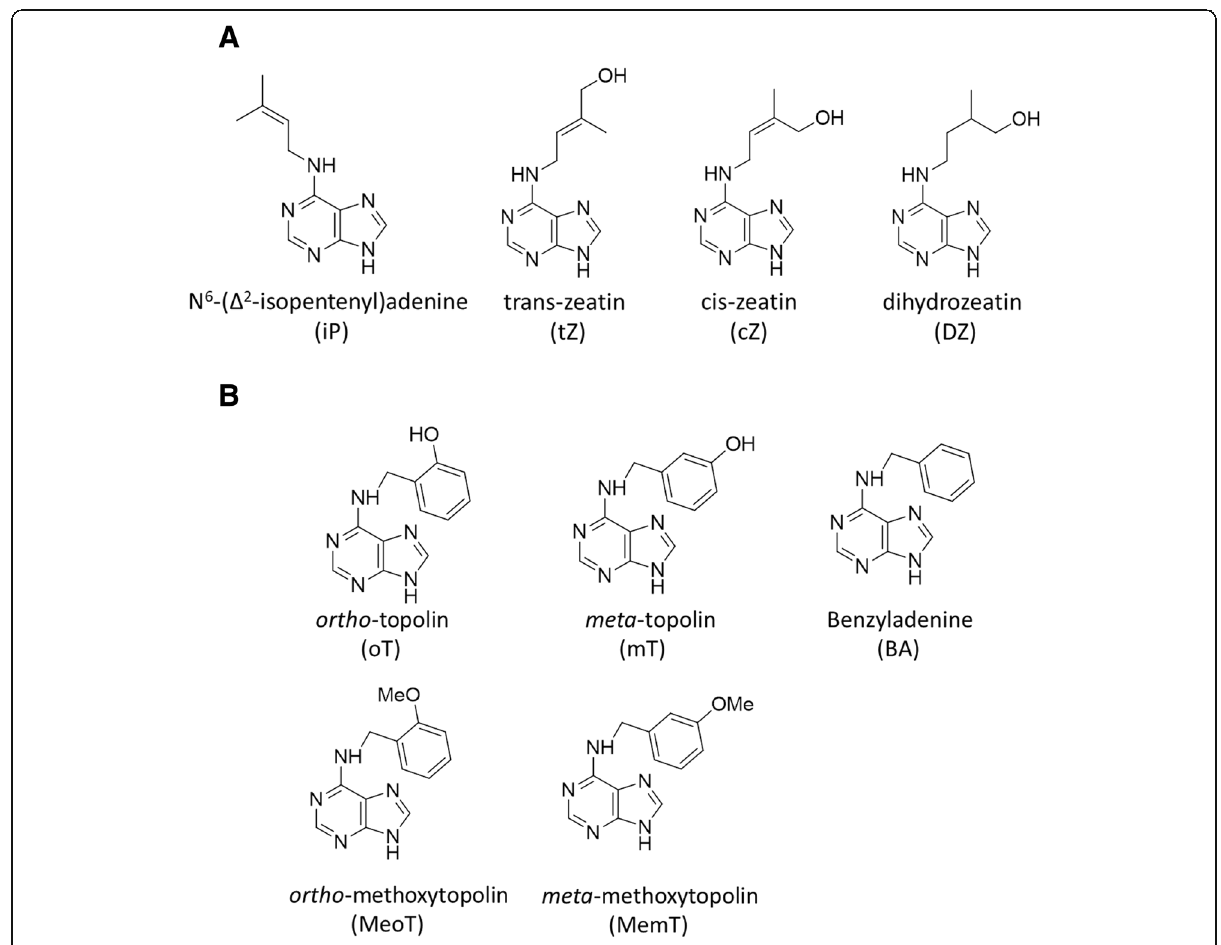
Fig. 1 The molecular structure of common active cytokinins. a The molecular structure of Isoprenoid CKs. There are four forms of Isoprenoid CKs, N 6 -( Δ 2 -isopentenyl) adenine (iP), trans-zeatin (tZ), cis-zeatin (cZ), dihydrozeatin (DZ). b The molecular structure of Aromatic CKs. There are five forms of Aromatic CKs, ortho -topolin(oT), meta -topolin(mT),benzyladenine(BA), ortho -methoxytopolin(MeoT), meta